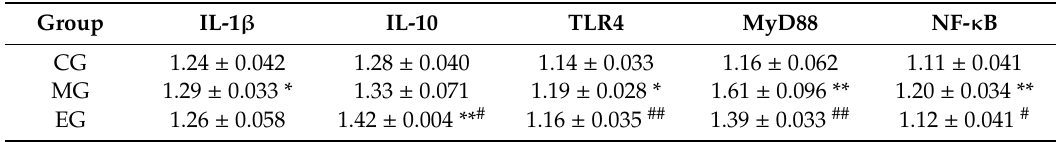
Table 5. RT–PCR results of inflammation-related factors in mouse hippocampus.